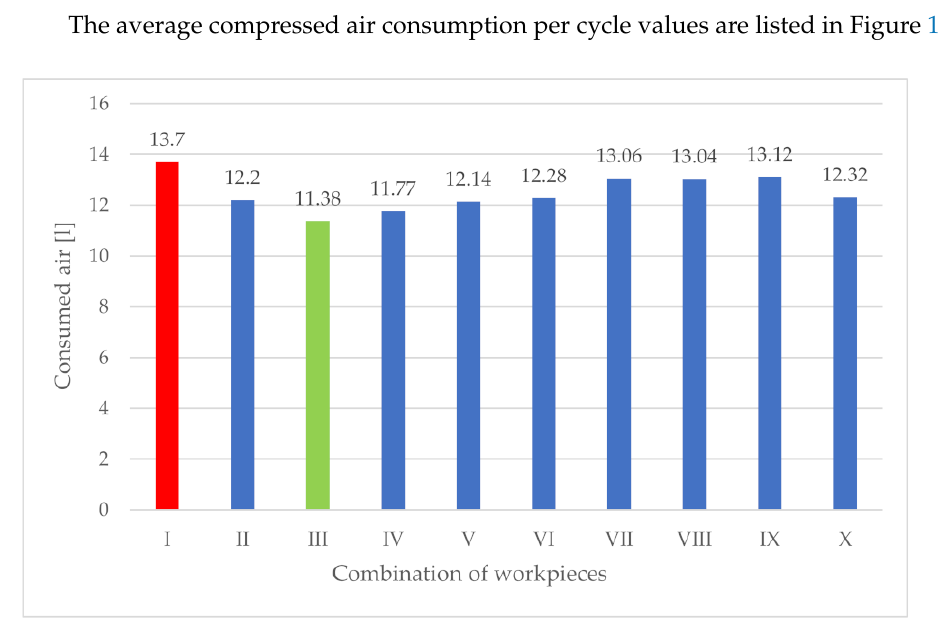
Figure 13. Average compressed air consumption of the system per